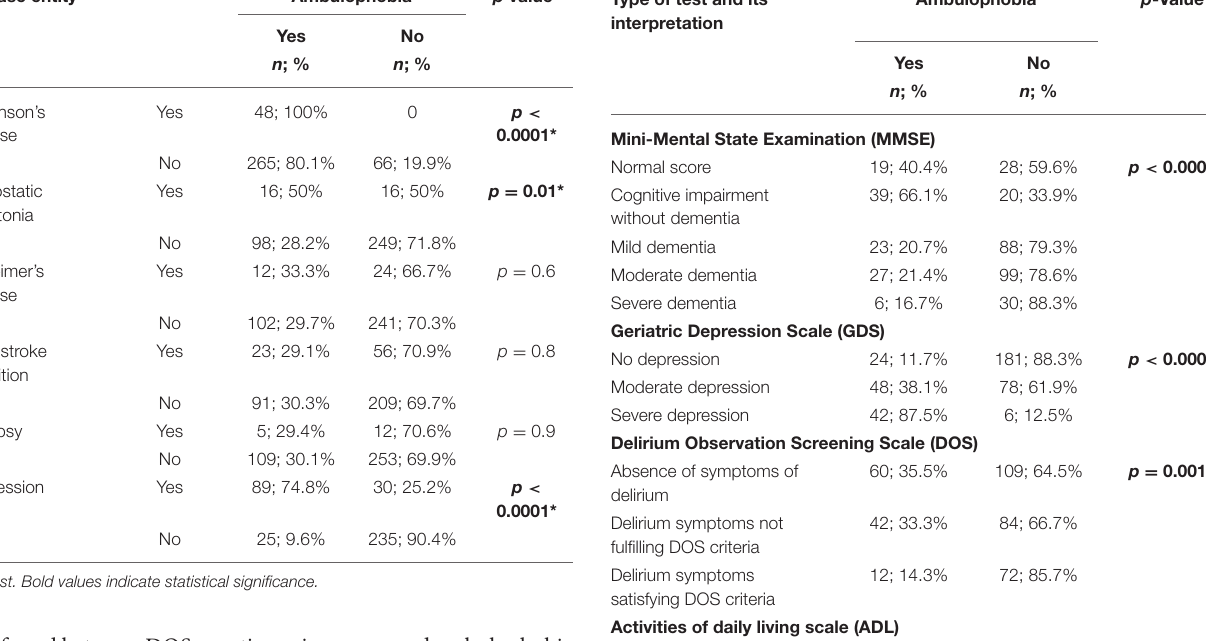
TABLE 3 | Occurrence of ambulophobia in the study group divided by the results of selected screening tests used in comprehensive geriatric assessment. Type of test and its